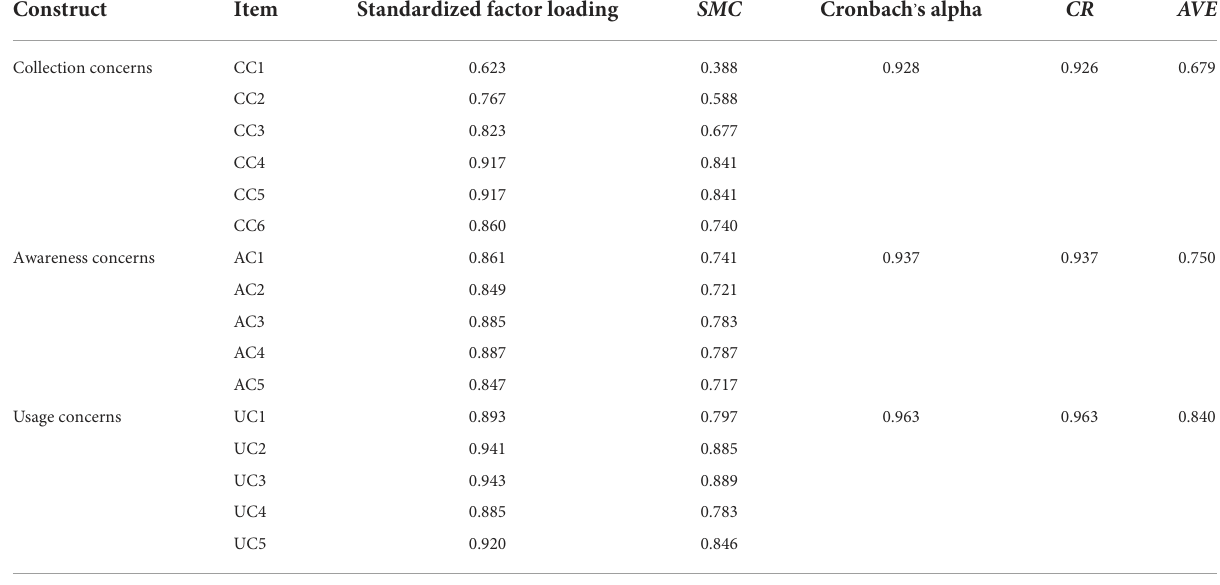
TABLE 8 Confirmatory factor analysis ( n = 287).